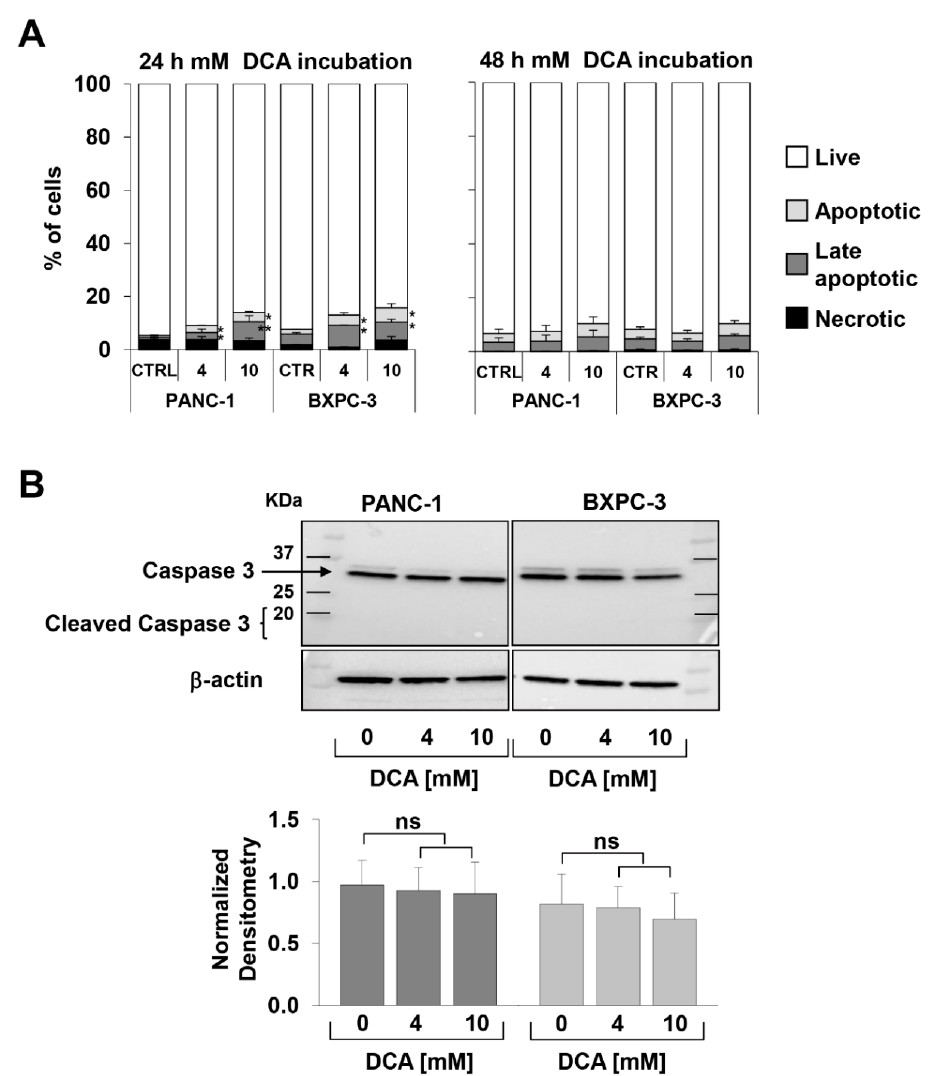
Figure 2. Effect of DCA on vital parameters and cell migration capacity, ( A ) measurement of early and late apoptotic and necrotic cells was performed by flow-cytometry as described in Material and Methods, cells were treated with 4 and 10 mM DCA for 24 h (left panel) and 48 h (right panel), data are expressed as percentage of total events analyzed and are the mean ± SEM of at least three independent experiments (* p < 0.05 vs. CTRL, ** p < 0.01 vs. CTRL); ( B ) expression of caspase 3, (upper panel) representative western blotting of total protein lysate, (lower panel) densitometric analysis (normalized to β -actin) of the uncleaved caspase 3 band, the bars are means ± SEM of three independent experiments under each condition; NS, not significant.